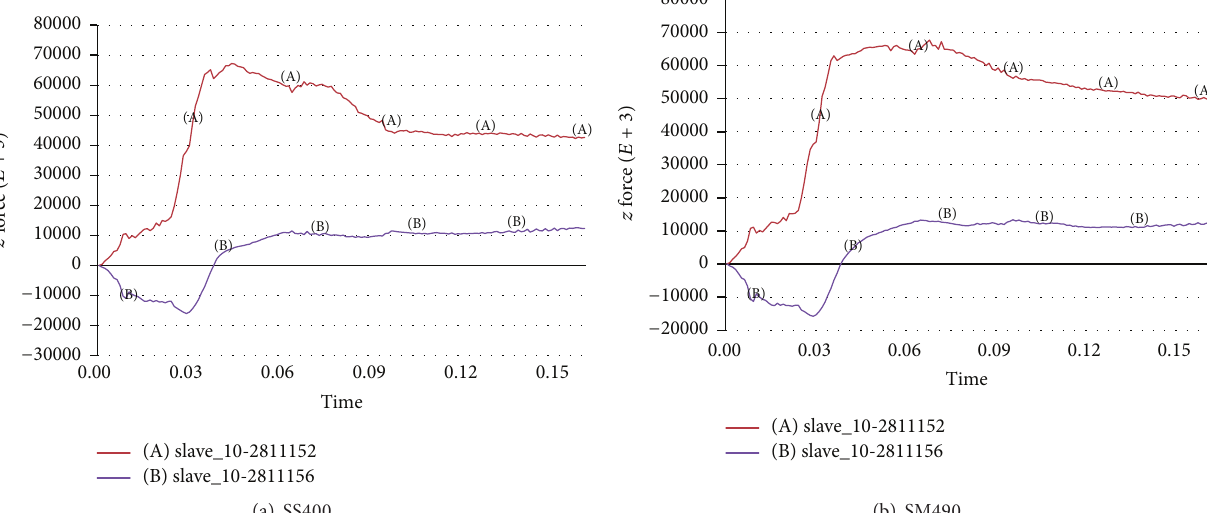
is exceeded during impact. The finite element